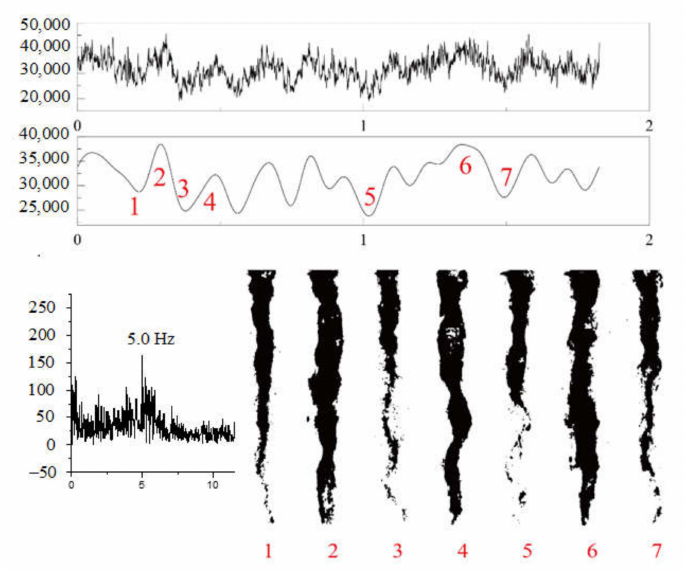
Figure 13. Pressure fluctuation and flow pattern for operating condition